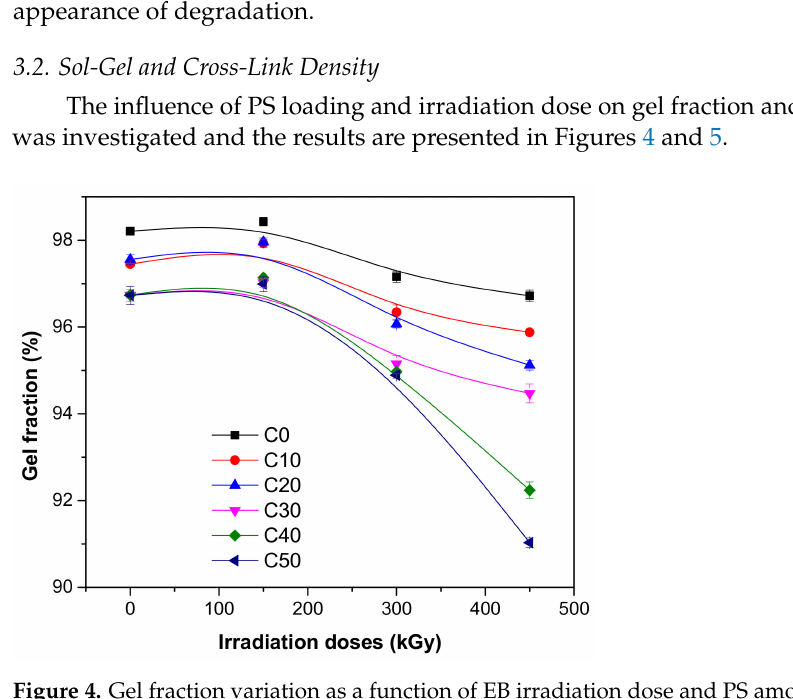
Figure 4. Gel fraction variation as a function of EB irradiation dose and PS amount.